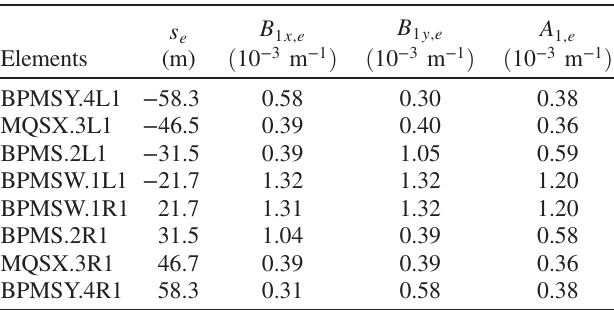
TABLE VI. Quadrupole components of the equivalent kick estimated from the simulated data of Sec. VII. The quadrupole components are calculated in eight different locations of IR1. s e is measured from IP1.